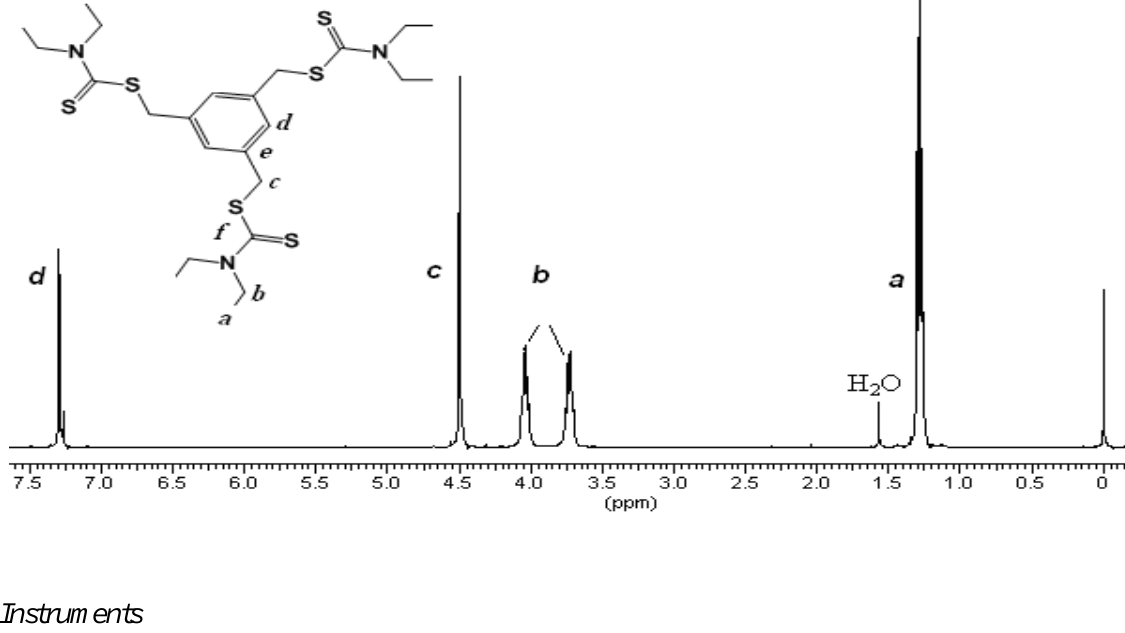
Figure 1. 1 H-NMR spectra of three-arm chain transfer agent (CTA) (400 MHz, CDCl